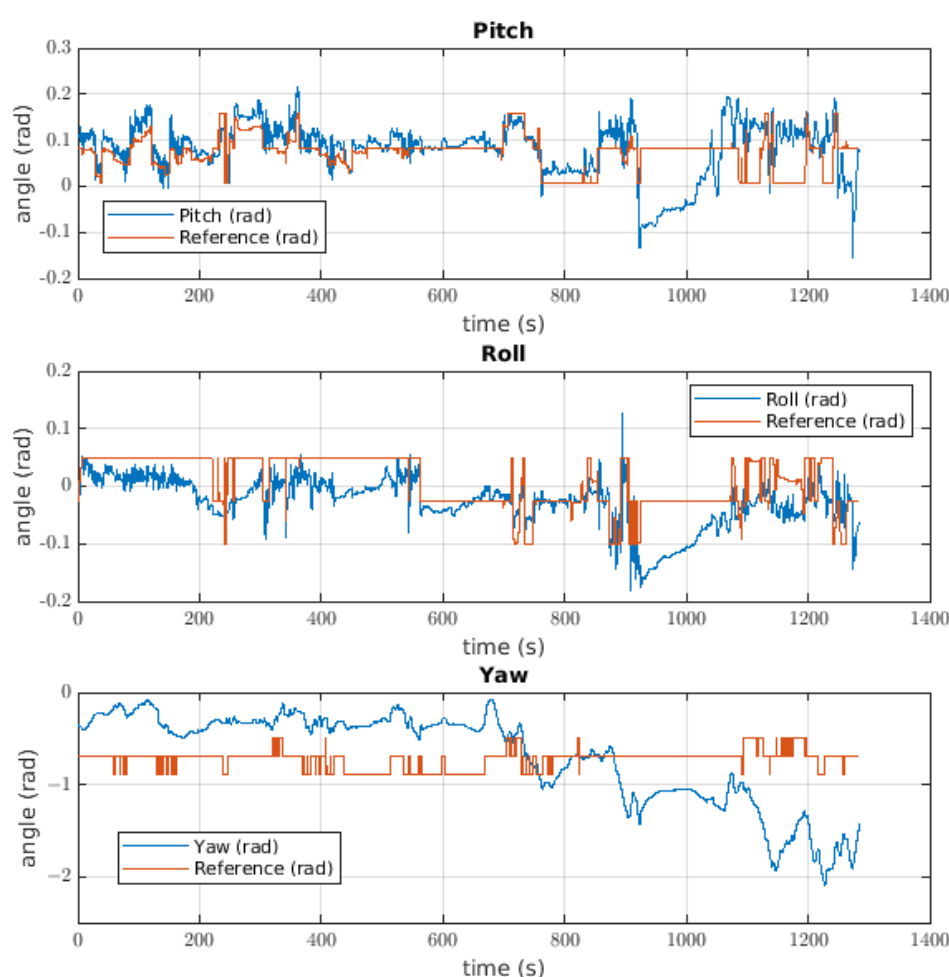
Figure 22. Attitude controller used when the robot was taking a